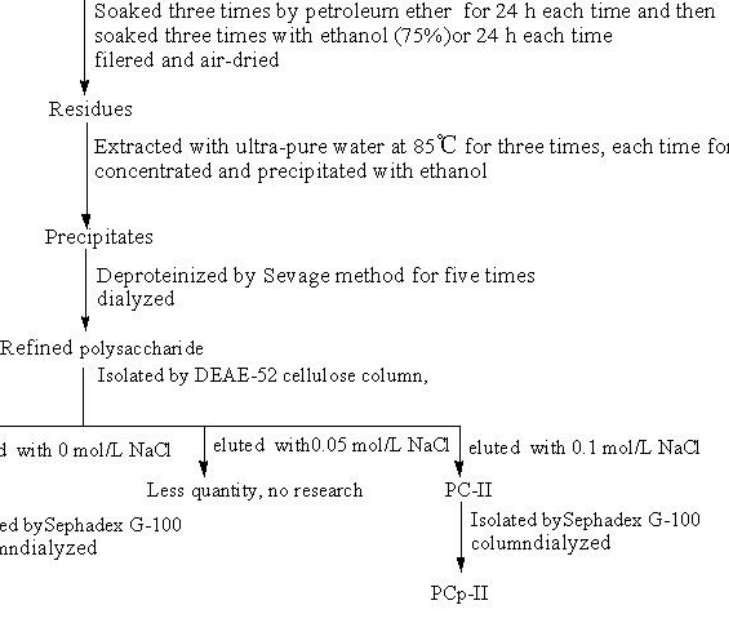
Figure 9. Isolation procedures of polysaccharide from P. corylifolia .